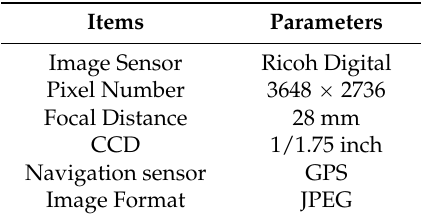
Table 1. The parameters of the image